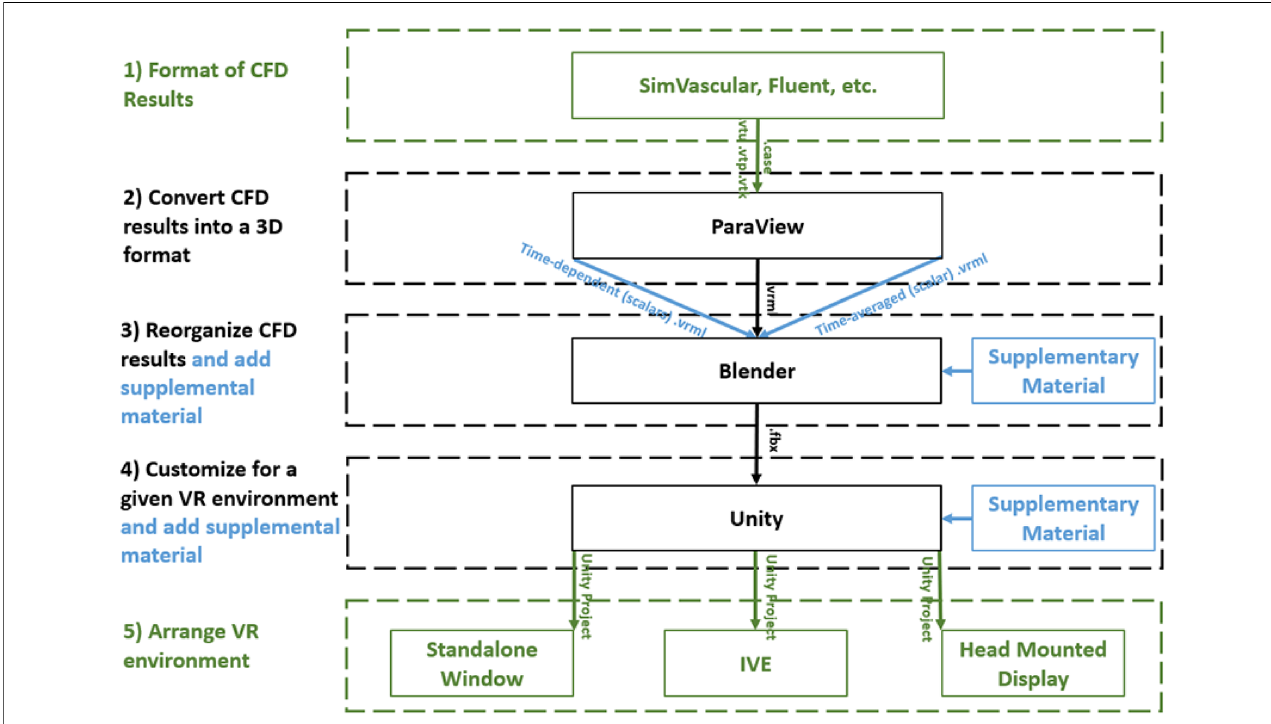
FIGURE 1 Diagram of the immersive visualization work fl ow after a CFD simulation is complete. CFD results in a (1) format of the simulation software are (2) converted into .vrml fi les (type of 3D geometry) before being (3) reorganized in Blender where supplementary material can be added. Simulation results and supplementary material are (4) customized within Unity for the given application and then (5) arranged for a given immersive virtual environment. black= necessary steps, blue=optional steps, green=user selects one of the